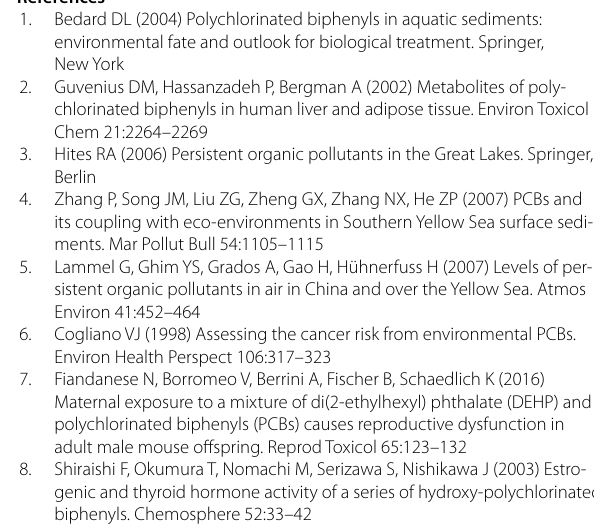
improve the reaction rate. The largest reduction in the energy barrier and increase in the reaction rate were obtained with benzene.